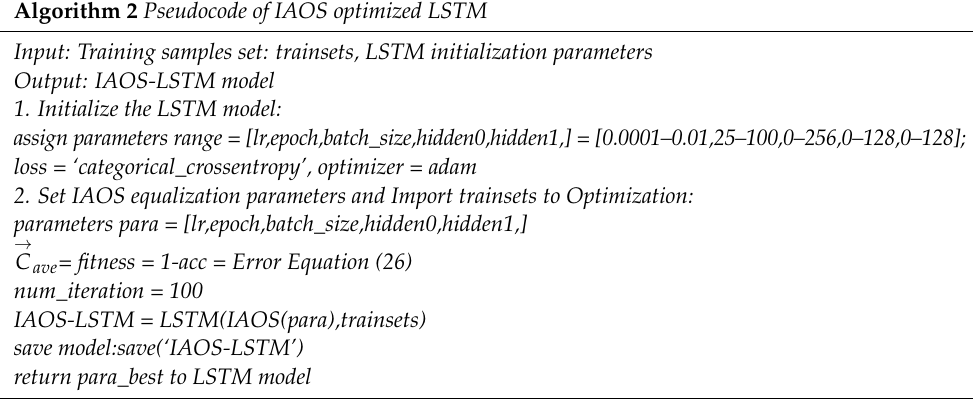
Algorithm 2 Pseudocode of IAOS optimized